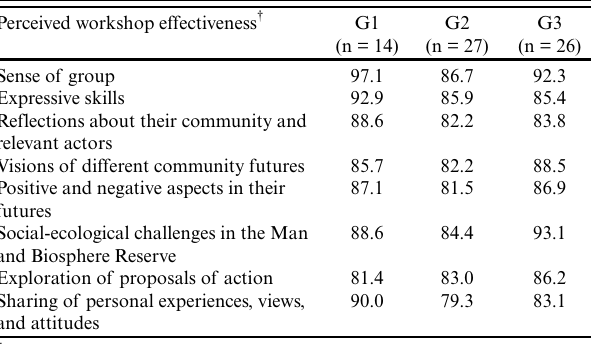
Table 2 . Evaluation of workshop effectiveness perceived by participants.